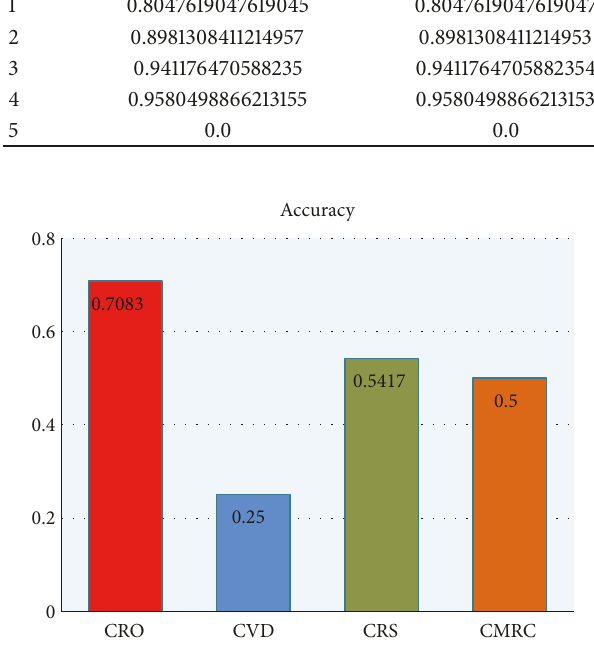
Figure 4: Comparison of accuracy for different congestion evalua- tion algorithms.